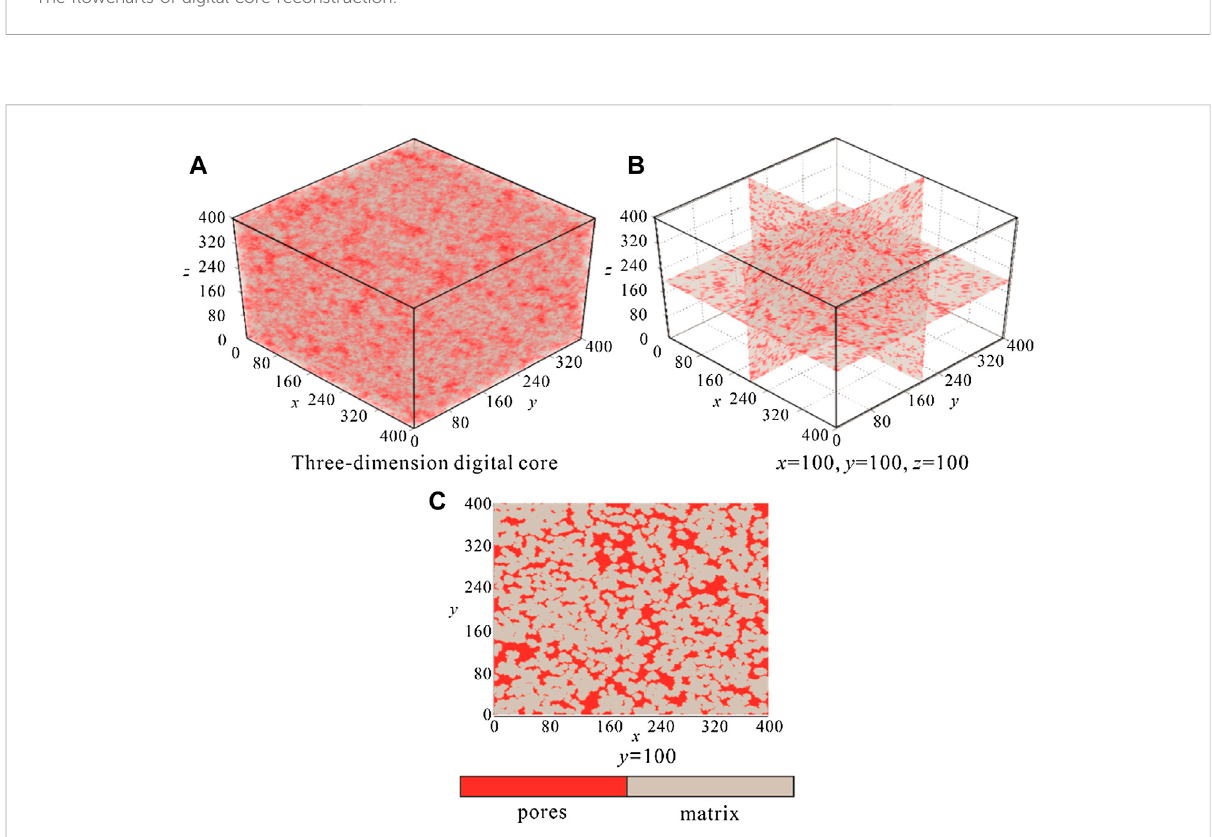
FIGURE 5 The fl owcharts of digital core